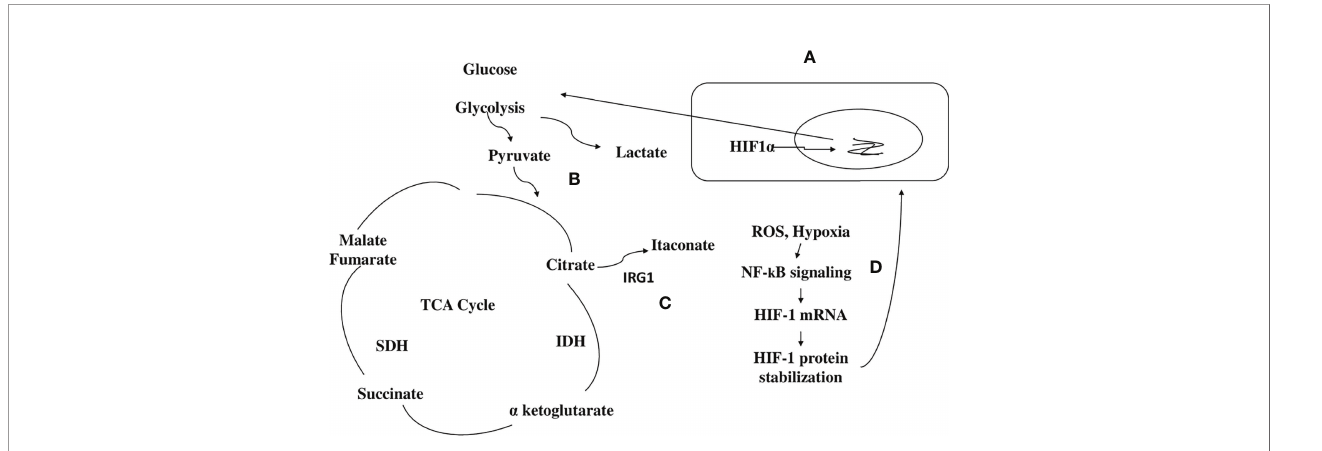
FIGURE 2 | Scheme hypothesizing how itaconate regulates TCA fl ow in monocytes/macrophages infected with a bacterial pathogen. (1) (A) During bacterial infection, activated macrophages (MQs) accumulate stabilized HIF-1 a , which subsequently translocates to the nucleus, initiating the transcription of genes related to glycolysis. (B) Activated MQs and other surrounding immune cells such as induced T cells have shown high glycolysis during infection that is accompanied by Warburg-effect metabolism (accumulation of lactate). (C) Immune responsive gene 1 (IRG1) links cellular metabolism with immune defense by catalyzing itaconic acid production in mouse and human macrophages, and itaconate modulates MQ metabolism and effector functions by inhibiting succinate dehydrogenase (SDH)- mediated oxidation of succinate and thus, controls succinate levels and function. (D) Instead of producing ATP, this metabolic switch repurposes succinate oxidation in the mitochondria to release bactericidal ROS catalyzed by SDH and isocitrate dehydrogenase (IDH). An organism like Pseudomonas aeruginosa can also sense ROS, which promotes an acquired change, the bio fi lm